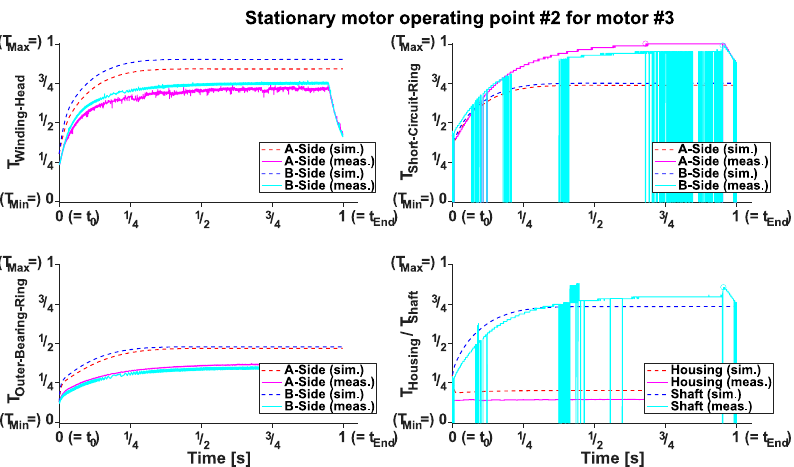
Figure 5. IM stationary operating point with telemetry sensor